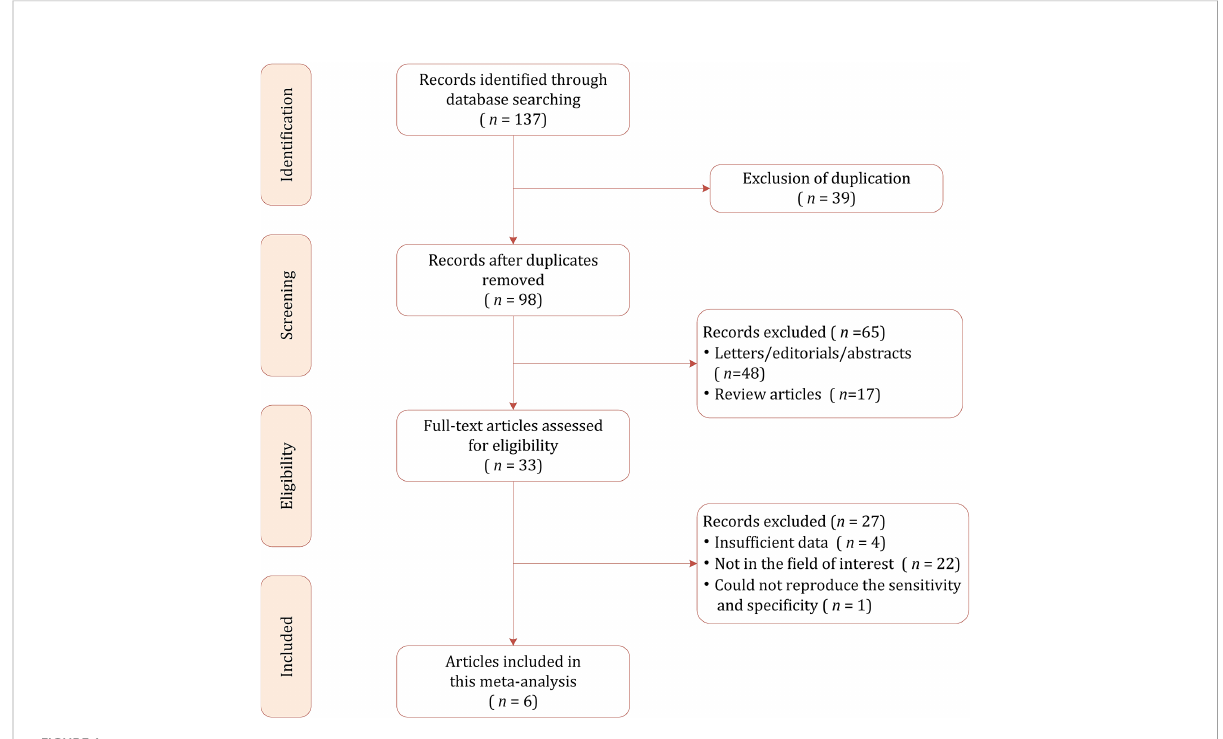
FIGURE 1 Study selection process for this systematic review and